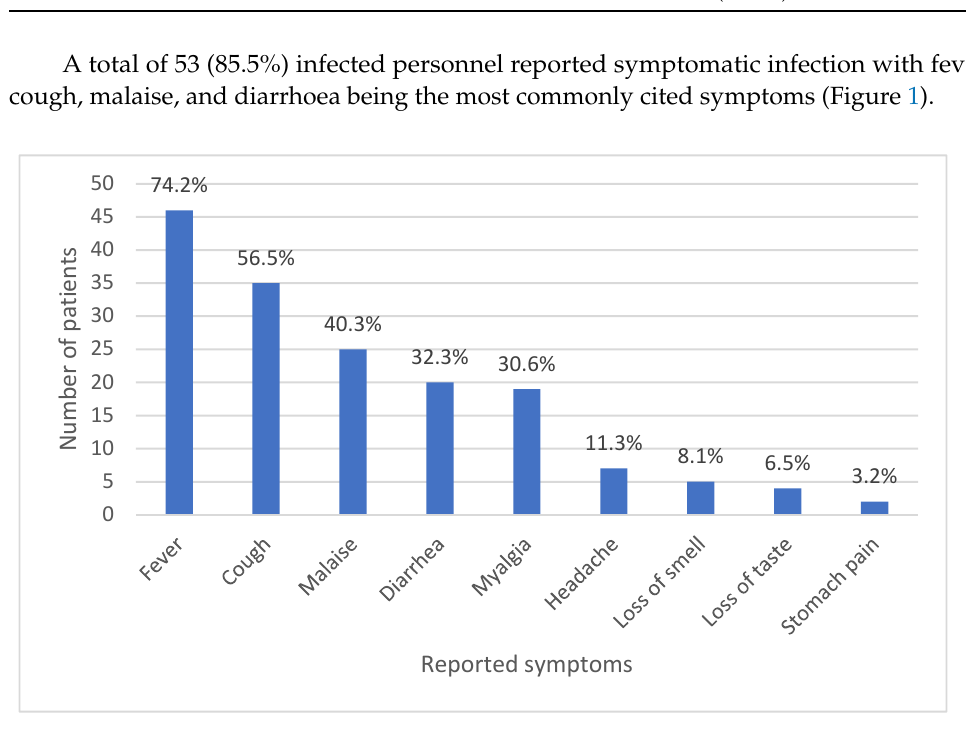
Figure 1. Acute symptoms of COVID-19 as reported by subjects contracting the infection. Average duration of signs and symptoms was 5.2 ± 4.2 days and ranged from 2–25 days, as described in Figure 2. Long-term adverse health complications were reported by 24 (38.7%) infected person- nel, and these were mostly respiratory and cardiovascular complications (Figure